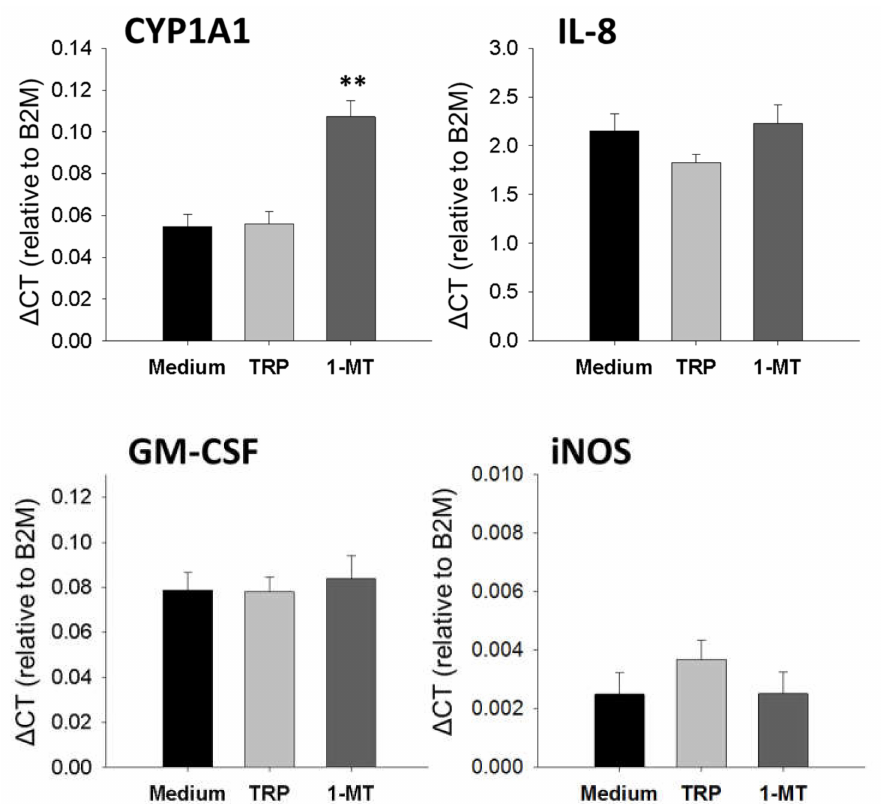
Figure A3. Effects of 1-MT and TRP contained in 1-MT on the mRNA expression of CYP1-A1, IL-8, GM-CSF and iNOS. Porcine lung fibroblasts were incubated with medium (unstimulated) or stimulated with TRP (5 µ M) or L-1-MT (100 µ M) for 3 h. Data are presented as means ± SE. n = 6, ** p <